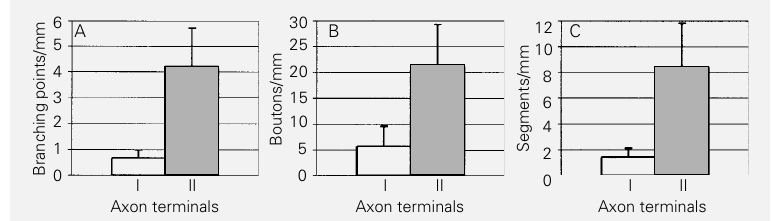
Figure 10 - Metric features of intrinsic axon terminals of V1 comparing density values per mm of axon length. A , Branch- ing points; B , boutons; C , seg-